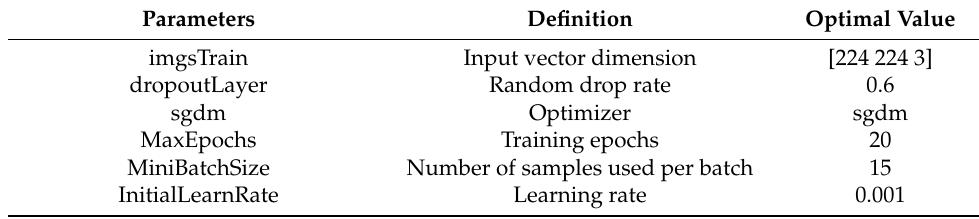
Table 2. GoogLeNet network model